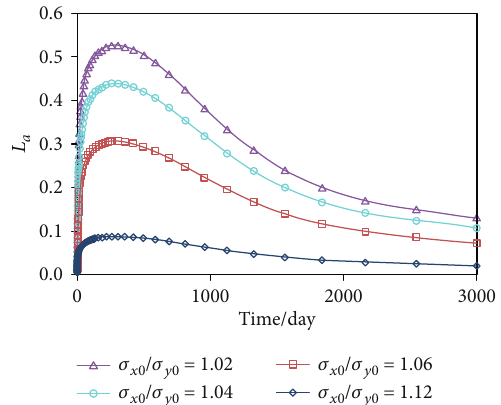
Figure 13: Initial horizontal stress ratio versus L